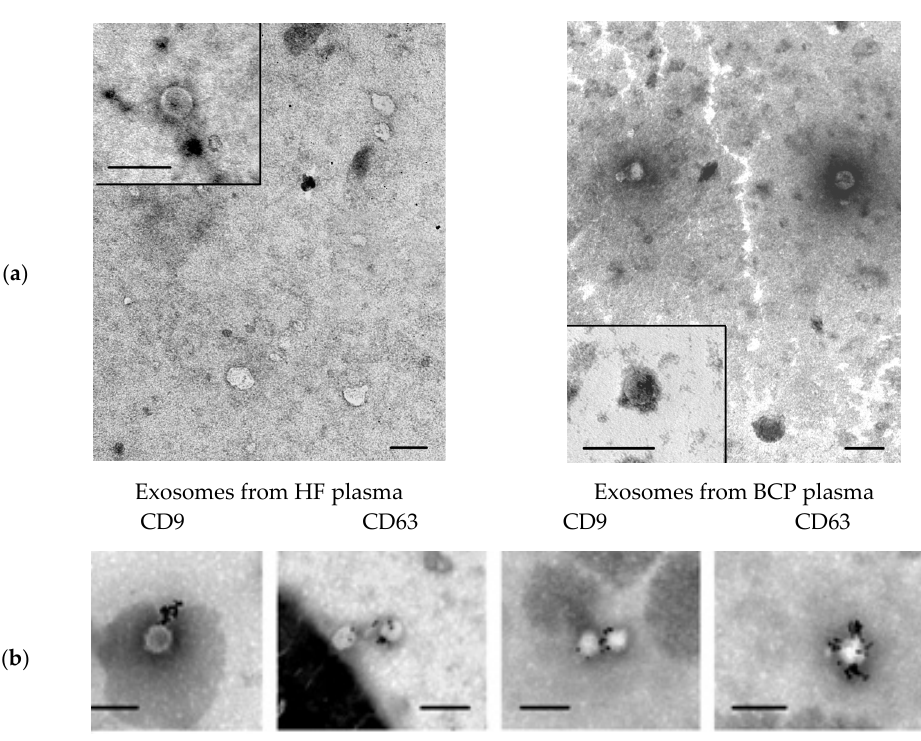
Figure 1. Electron microscopy. ( a ) Total view of exosome preparation obtained from blood plasma of HFs and blood plasma of BCPs. Inserts show exosomes. Scale bars correspond to 100 nm, negative staining by phosphotungstate acid. ( b ) Immunogold labeling of plasma exosomes in blood of HFs and BCPs based on electron microscopy data. Exosomes were incubated with monoclonal antibodies to CD63 or CD9 with subsequent detection by conjugate of protein A and gold nanoparticles. Scale bars correspond to 100 nm. Negative staining is shown by phosphotungstic acid.